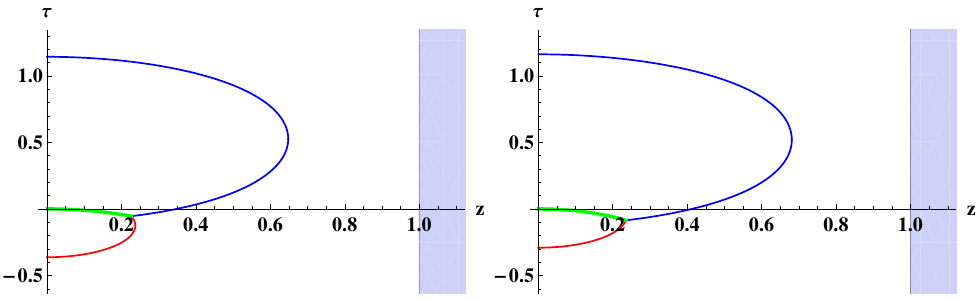
Figure 5 . a) Geodesic configuration for ∆ 1 = ∆ 2 = 30 , ∆ 3 = 42 , τ 2 = 1 . 15 , τ 1 = − 0 . 37 . b)